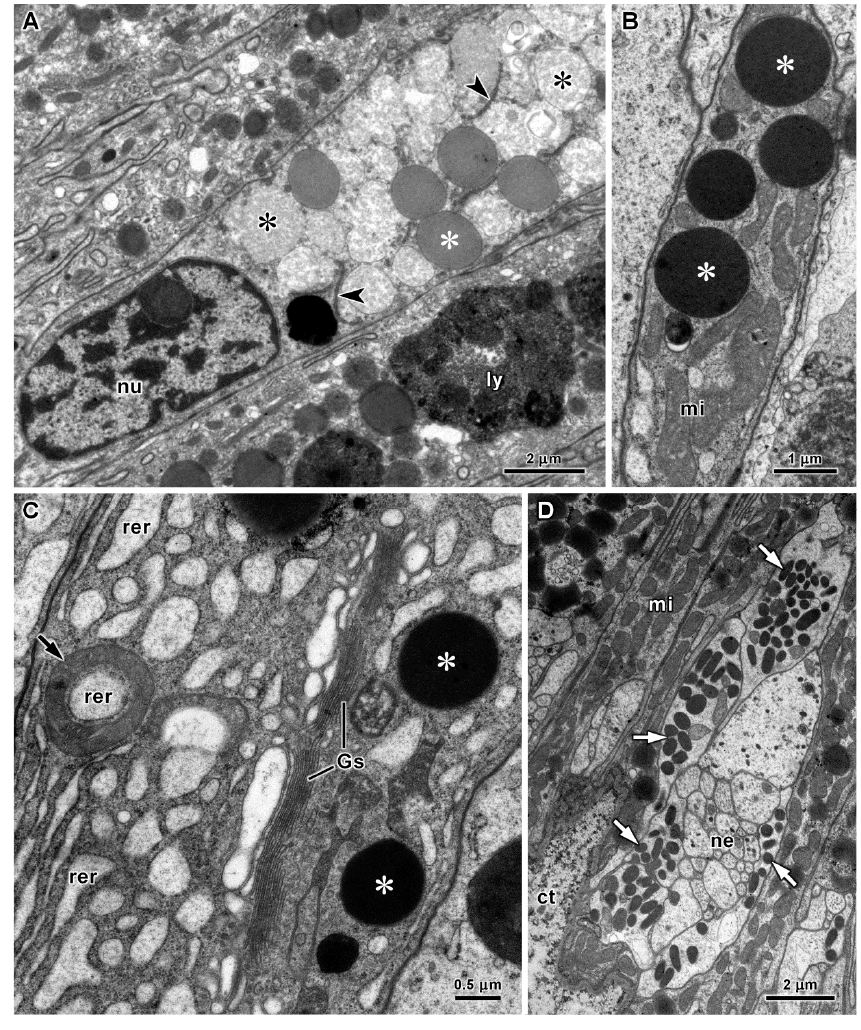
Figure 14. Ultrastructure of the posterior intestine in C. angulata ( A ) and A. fascicularis ( B – D ). ( A ) Mucus-secreting cell with vesicles of low and median electron density (asterisks) and a few rough endoplasmic reticulum cisternae (arrowheads). ( B ) Apical region of a narrow basophilic cell with electron-dense secretory vesicles (asterisks). ( C ) Electron-dense vesicles (asterisks), rough endoplas- mic reticulum cisternae (rer), Golgi stacks (Gs) and a mitochondrion with a ring-shaped section (ar- row) surrounding a portion of endoplasmic reticulum in a basophilic secretory cell. ( D ) Basal cells with oval electron-dense vesicles (arrows) around an intraepithelial nerve terminal (ne). ct—con- nective tissue, ly—lysosome, mi—mitochondria, nu—nucleus.